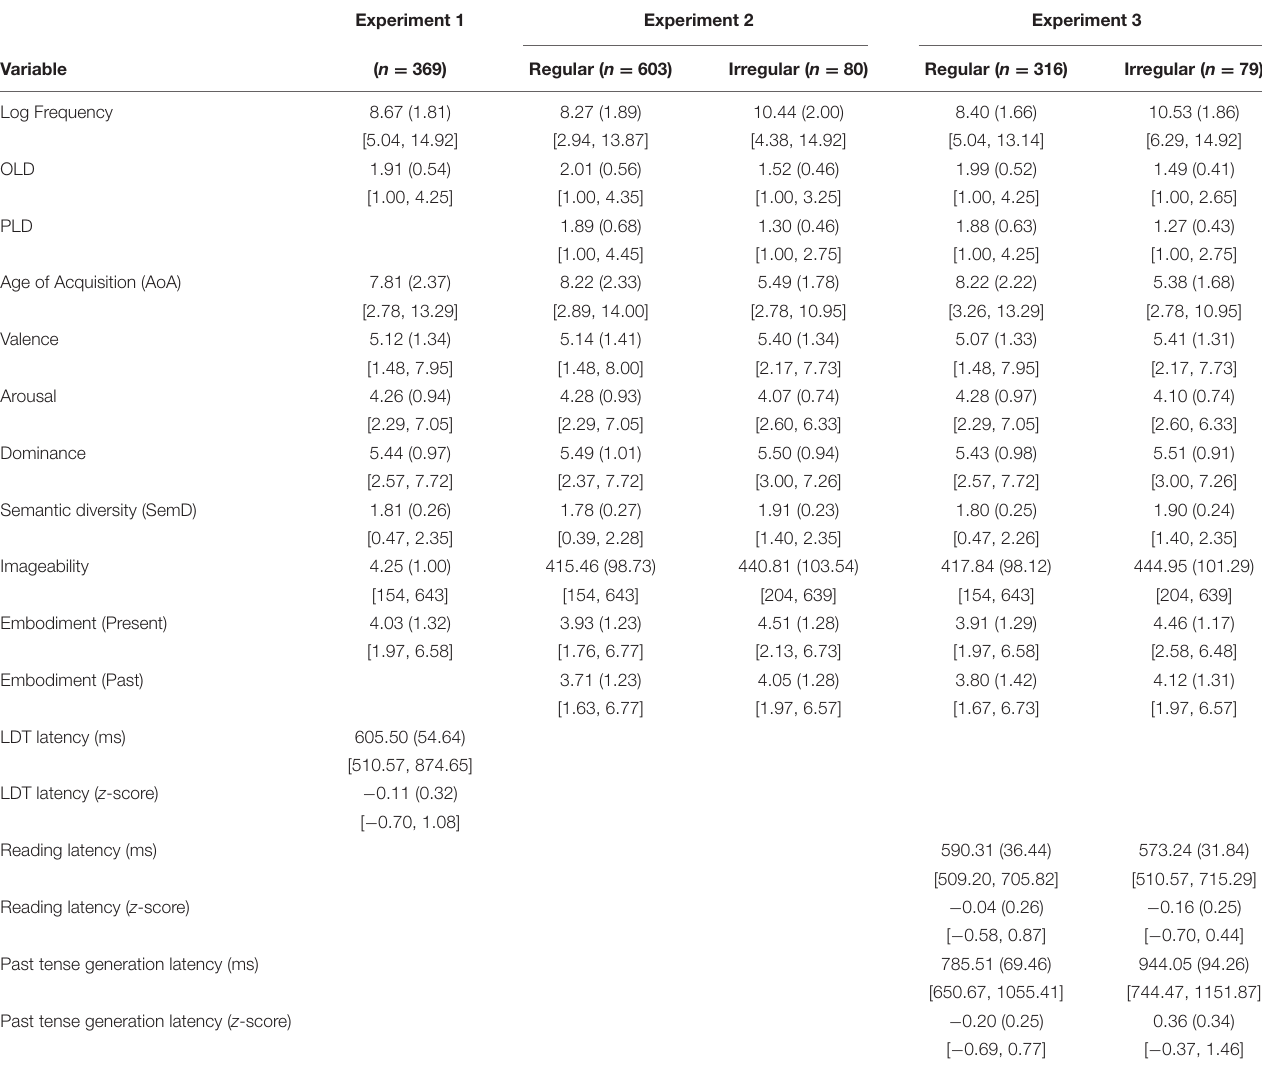
TABLE 1 | Mean descriptive statistics (standard deviations in parentheses; minimum and maximum values below) for verb stimuli in Experiments 1 (LDT), 2 (Embodiment Ratings), and 3 (Reading and Past Tense